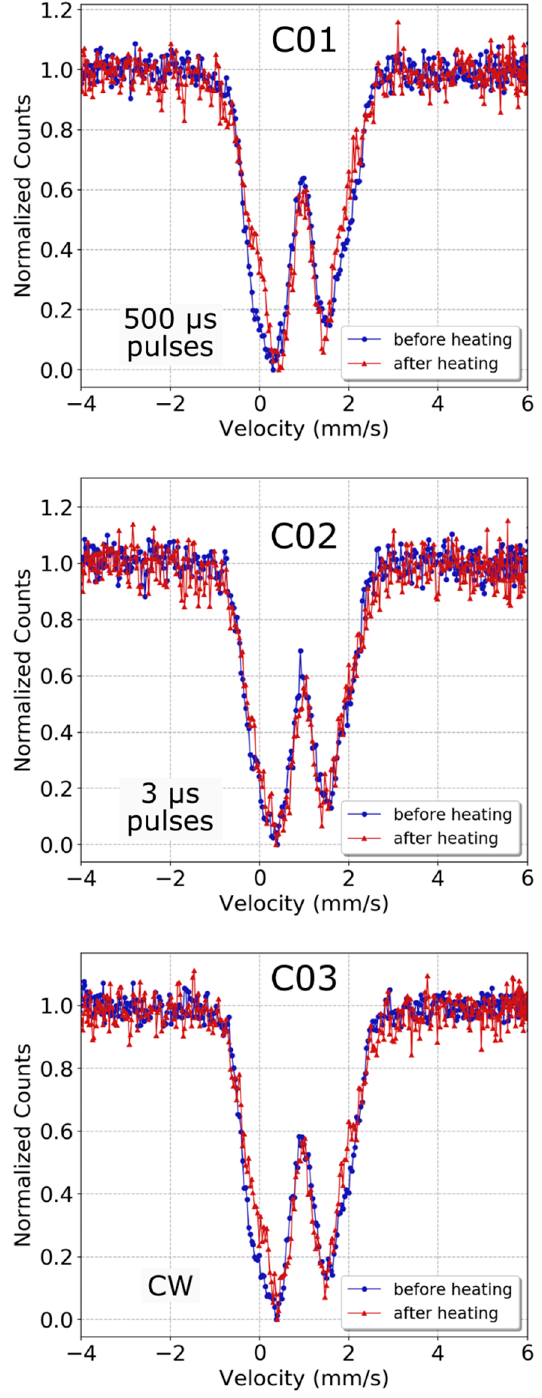
Figure 4. Normalized SMS spectra collected from each ferropericlase crystal, before and after heating at 30 GPa (Experiment 1). Blue circles correspond to absorption spectra collected before heating and red triangles correspond to absorption spectra collected from the quenched samples. Solid lines are guides for the eye. The spectra are normalized from 0 to 1 that correspond to the lowest count point (i.e., maximum absorption) and the average of the baseline, respectively.